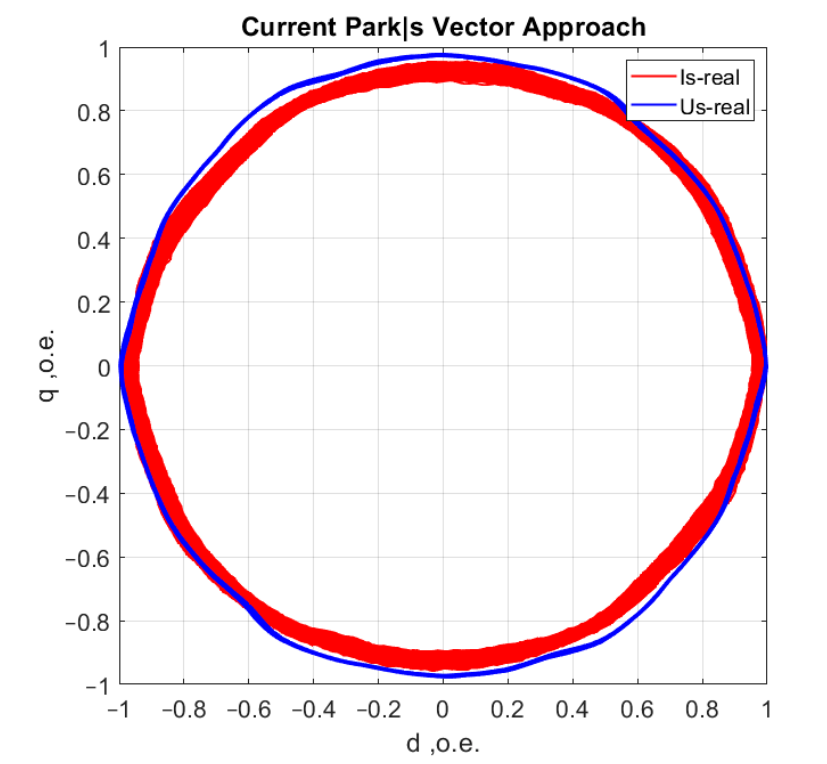
Figure 17. AM current consumption (red) and supply voltage (blue).